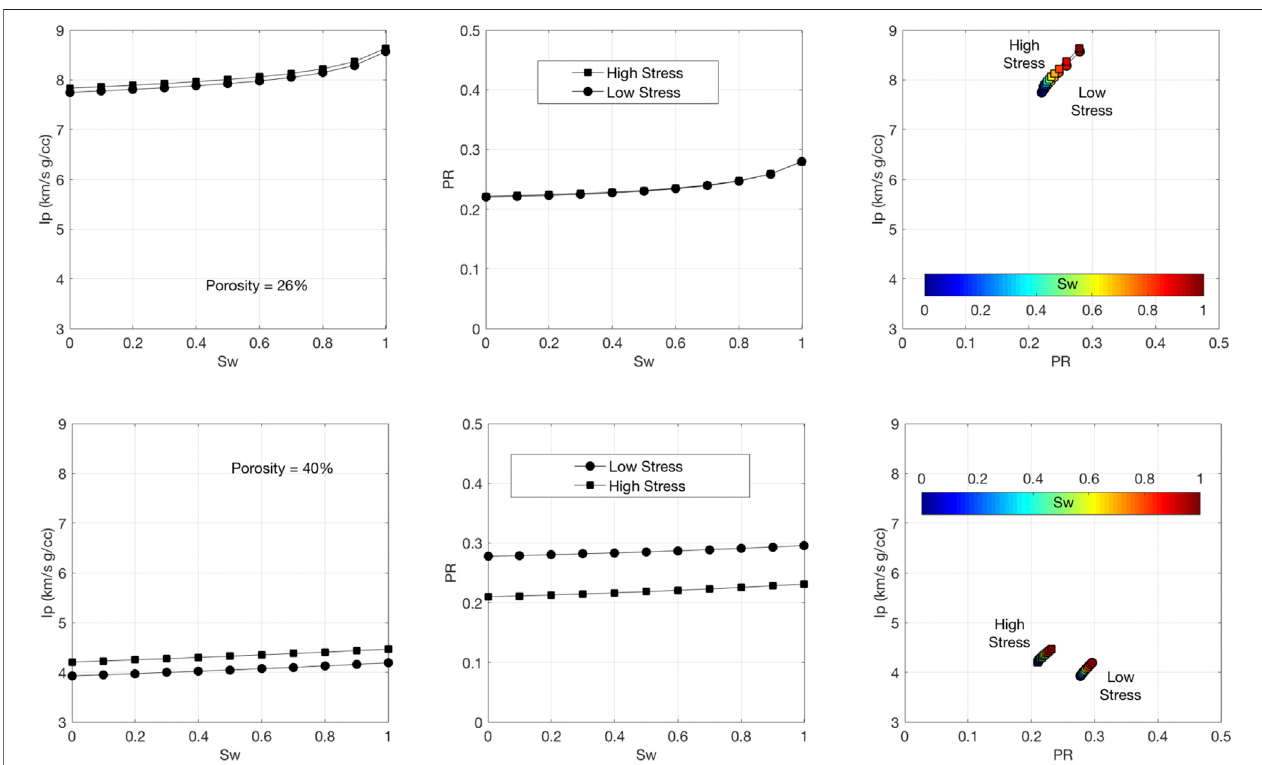
FIGURE 2 | I p (left) and ] (center) vs. S w as computed from the dry-rock data using fl uid substitution. Circles are for the low-stress data, while squares are for the high-stress data. Top: Sample with porosity 26%. Bottom: Sample with porosity 40%. The third frame in each row shows I p vs. ] cross-plots color-coded by S w .